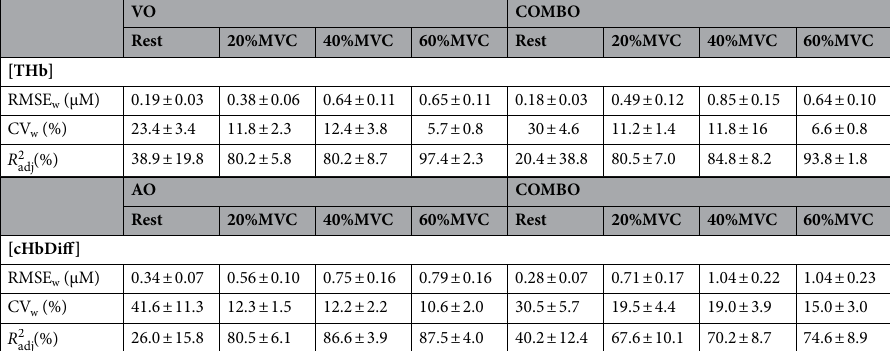
Table 1. Goodness-of-fit statistics for the curve fitting procedures applied on the total haemoglobin ([THb]) and corrected haemoglobin difference ([ c HbDiff]) waveforms during the venous, arterial and combined occlusions. Values represent means ± SEM. VO, AO and COMBO: venous, arterial and combined occlusions, respectively. MVC: maximal voluntary contraction; RMSE w : weighted root mean squared error; CV w : weighted coefficient of variation; R 2 adj : Adjusted coefficient of